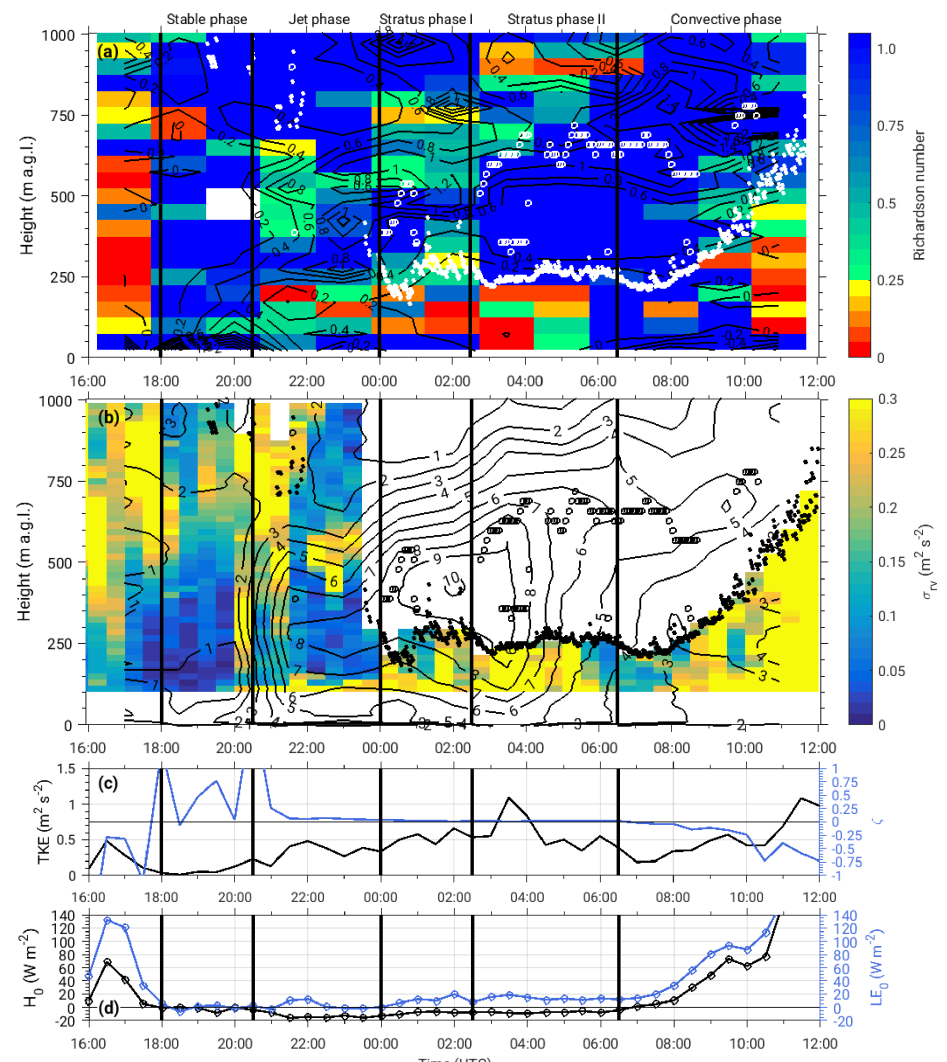
Figure 5. (a) The gradient Richardson number shown in color is calculated from radiosonde measurements. Black isolines show the vertical potential temperature gradient in K (100m) − 1 calculated from radiosonde data. The white dots show CBH and open white circles denote CTH. (b) Variance of the radial velocity obtained by Doppler lidar measurements. The black contours show horizontal wind speed (in ms − 1 ) measured by radiosondes, while black dots show CBH and open black circles denote CTH. (c) Time series of the near-surface 30min averaged TKE (black) and stability parameter ( ζ , blue). (d) Time series of the near-surface sensible heat flux ( H 0 , black) and latent heat flux (LE 0 , blue) measured by the energy balance station. The vertical black lines indicate the beginning of five different phases observed during this